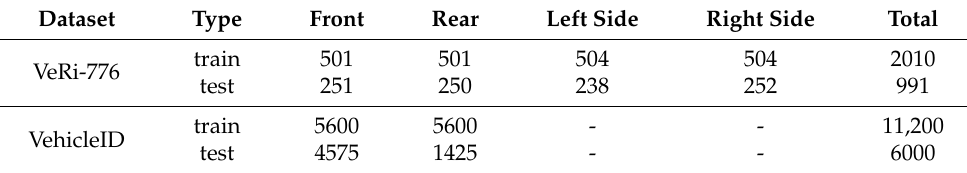
Table 4. The number of pose annotations on VeRi-776 and VehicleID datasets.